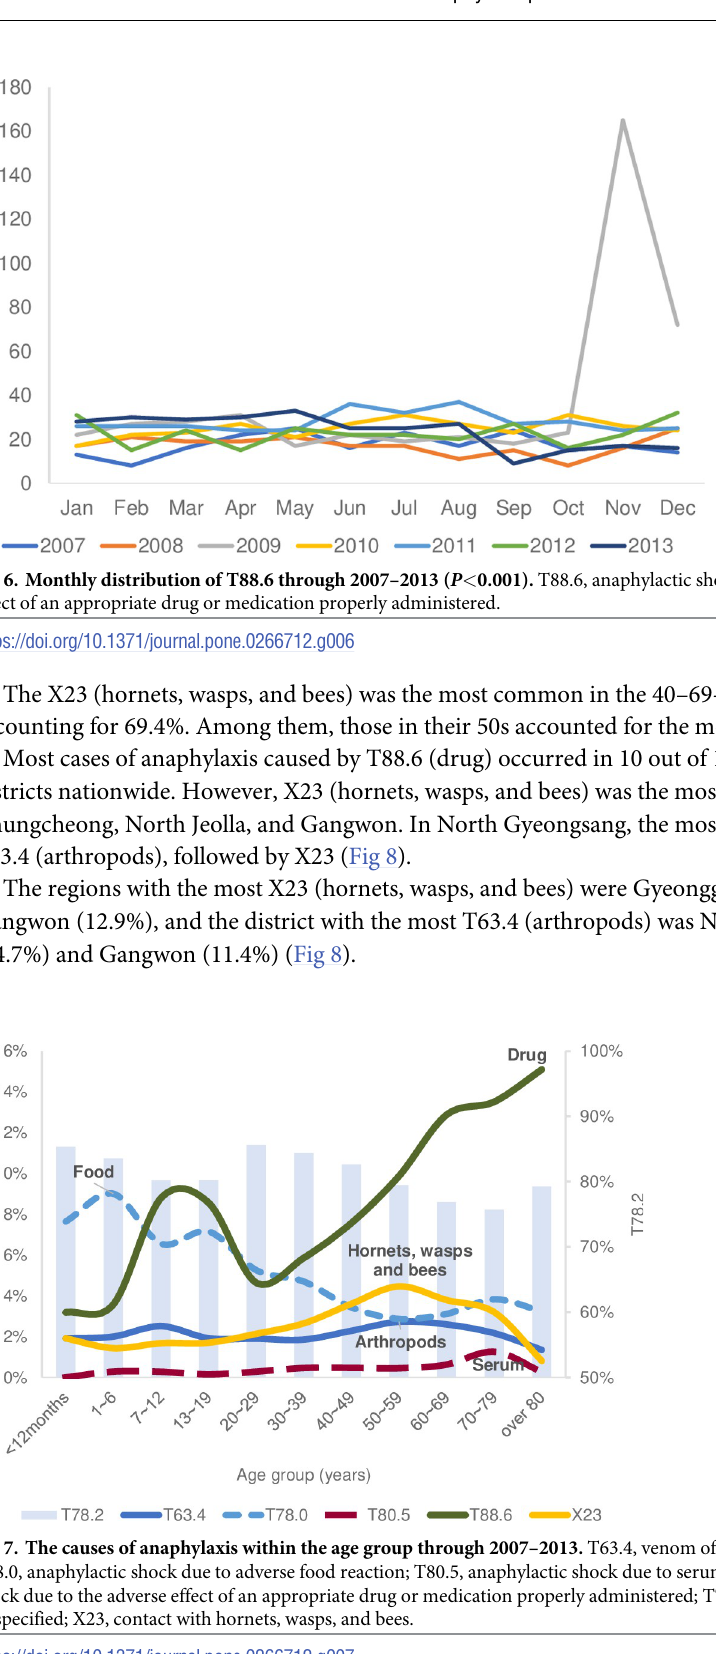
Fig 7. The causes of anaphylaxis within the age group through 2007–2013. T63.4, venom of other arthropods; T78.0, anaphylactic shock due to adverse food reaction; T80.5, anaphylactic shock due to serum; T88.6, anaphylactic shock due to the adverse effect of an appropriate drug or medication properly administered; T78.2, anaphylactic shock, unspecified; X23, contact with hornets, wasps, and bees.